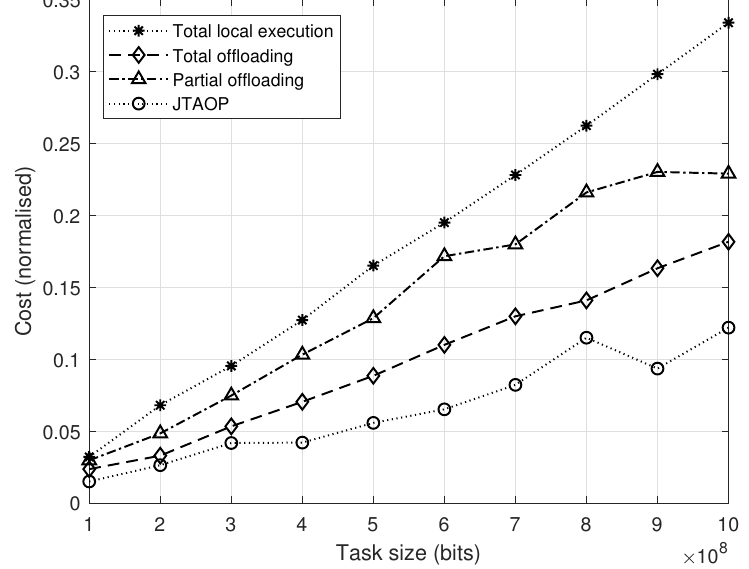
Figure 5. Cost vs. task size.